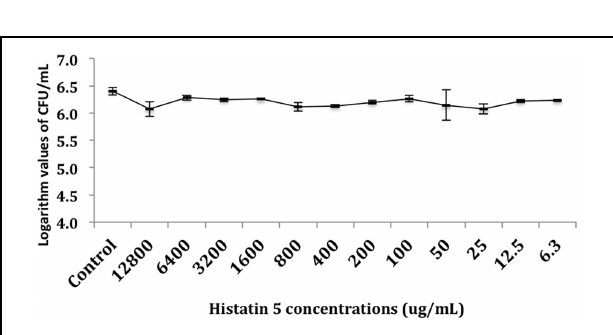
FIGURE 3 | Logarithm values of CFU/mL − 1 when histatin 5 was in different concentrations, ranged from 12,800 to 6.3 µ g/mL, were incubated for 24 h over a 48 h C. albicans